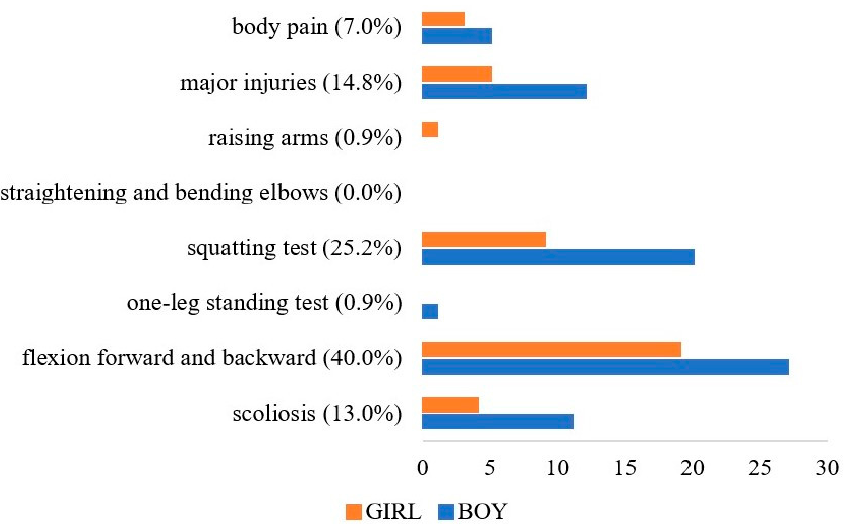
Figure 2. The proportion participants with each musculoskeletal condition. These data were obtained among children with locomotive syndrome by performing musculoskeletal examination. Table 2. Physical function outcomes and questionnaire.